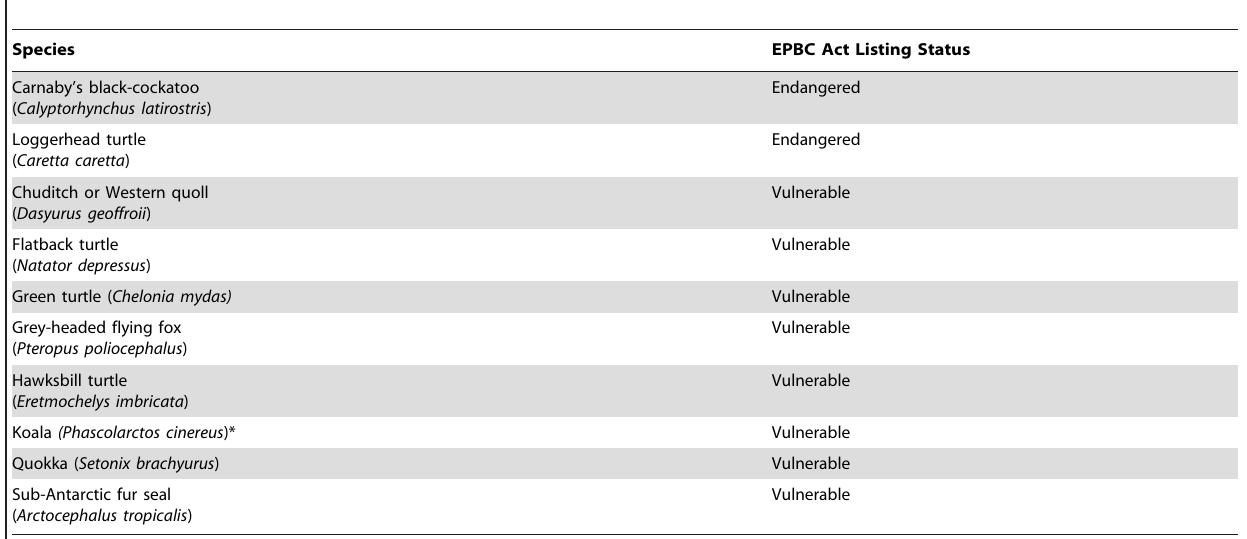
Table 5. Threatened species for which data was captured through the pilot